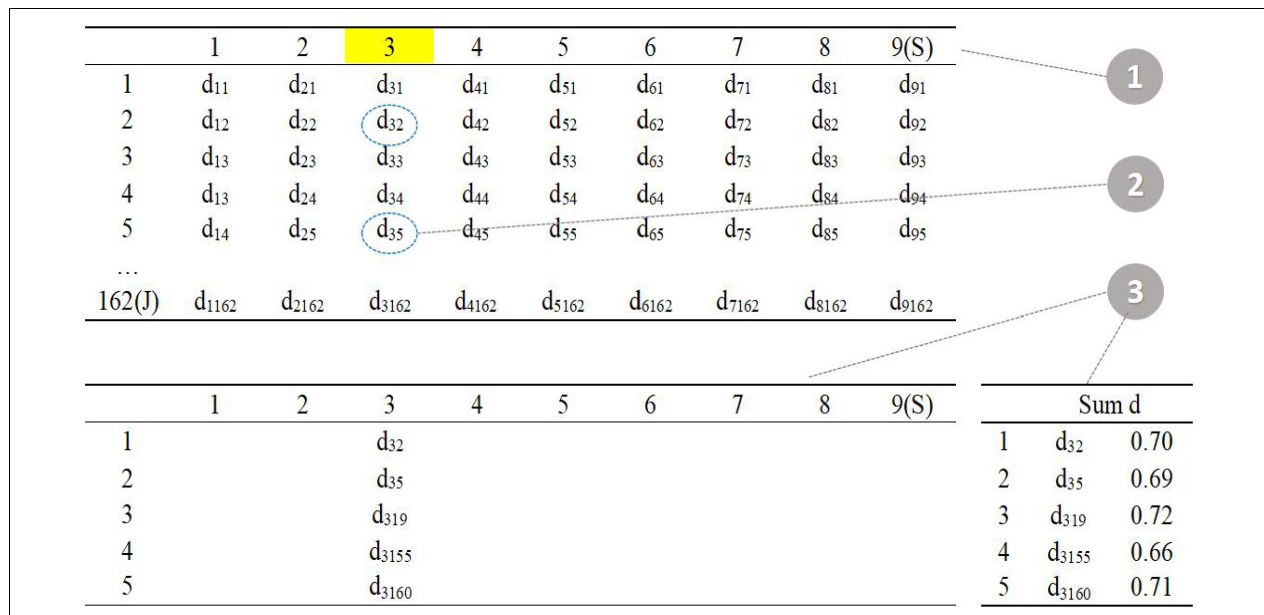
FIGURE 3 | Procedure